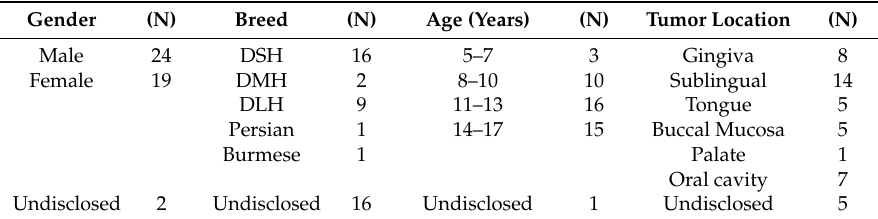
Table 1. Feline oral squamous cell carcinoma (OSCC) cases. DSH: domestic short hair, DMH: domestic medium hair, DLH: domestic long